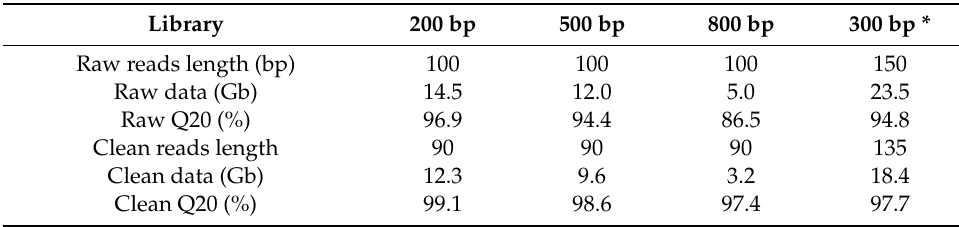
Table 2. Basic statistics for the sequencing